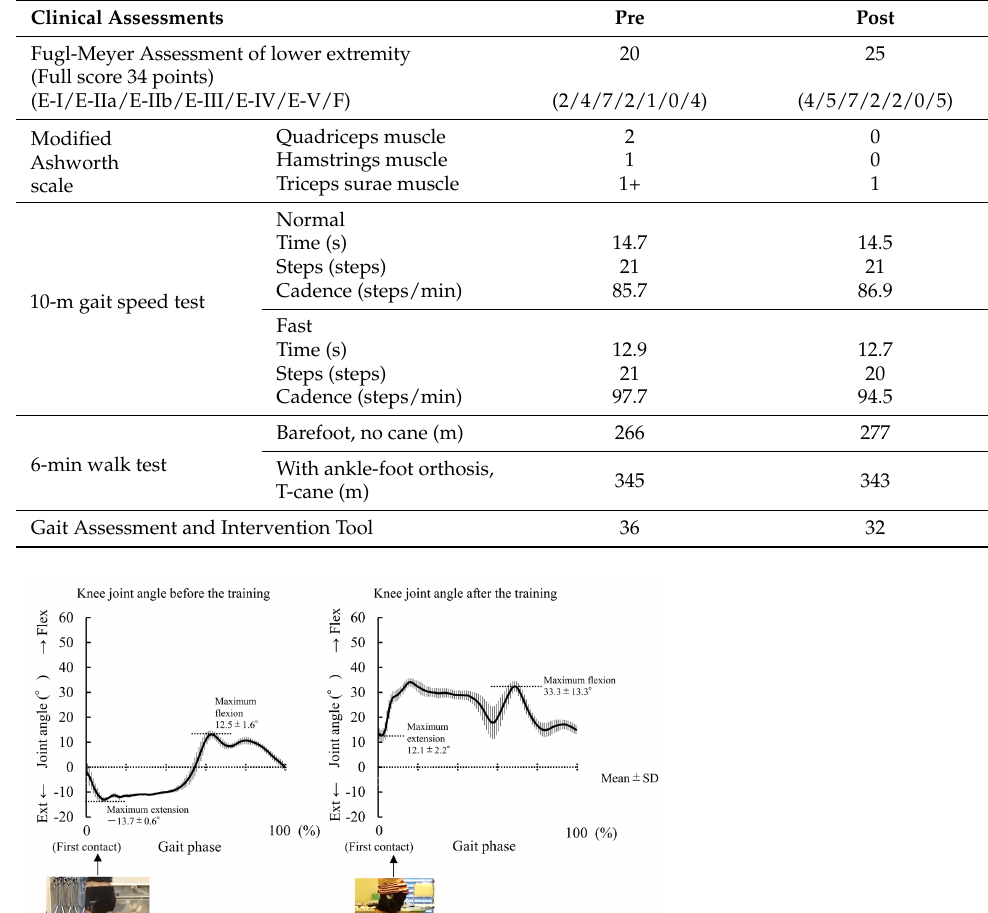
Table 3. Results of clinical assessments in Experiment 2 (Patient I).